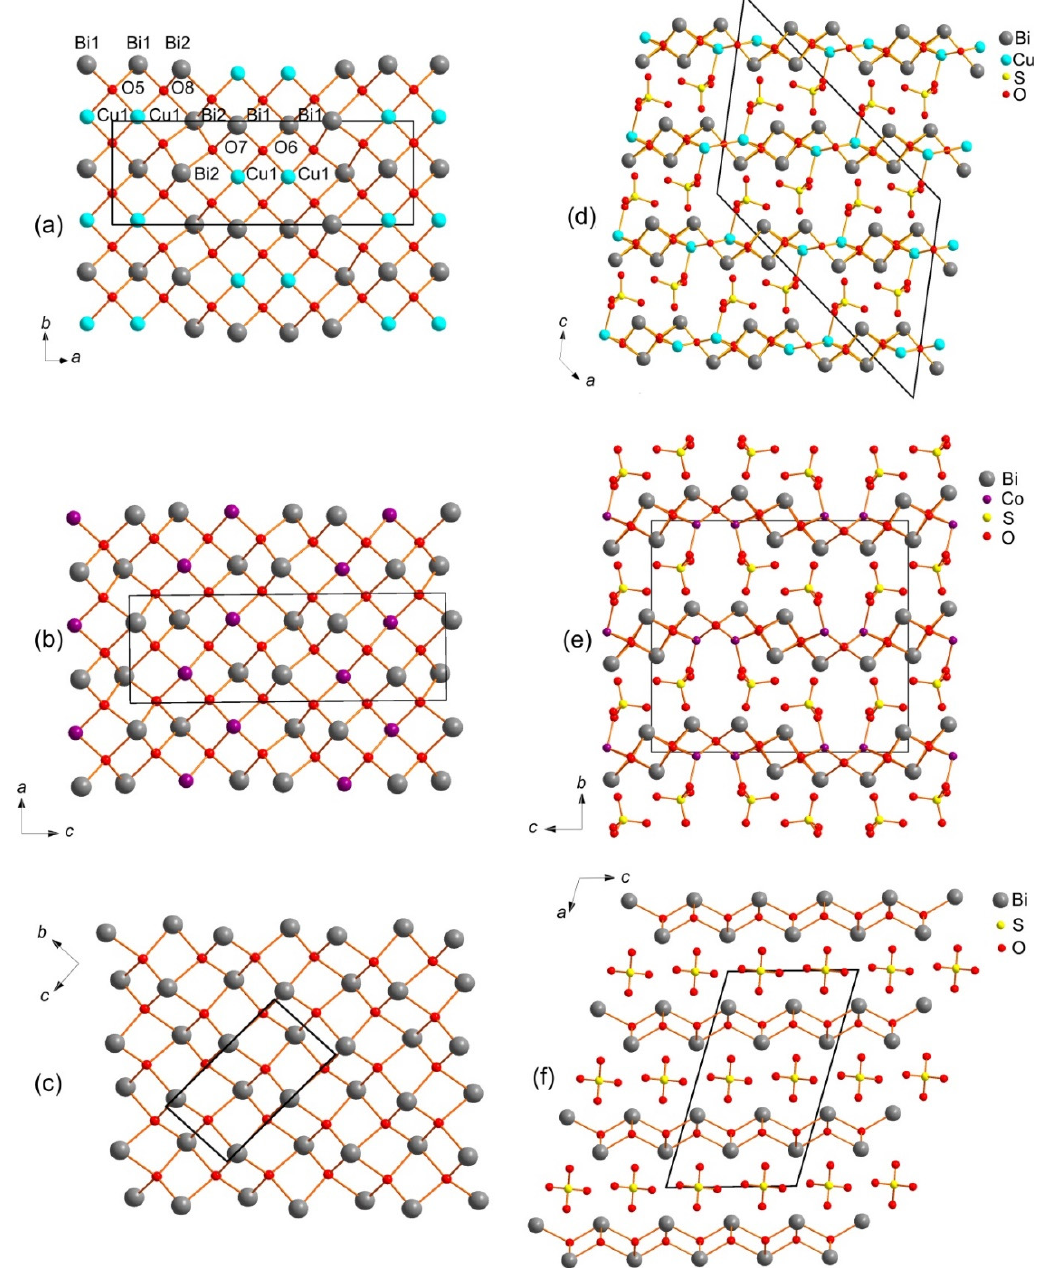
Figure 3. [Bi 2 CuO 3 ] 2+ layer ( a ) in the crystal structure of [Bi 2 CuO 3 ](SO 4 ), [Bi 2 CoO 3 ] 2+ layer ( b ) in the structure of [Bi 2 CoO 3 ](SO 4 ) and [Bi 2 O 2 ] 2+ layer ( c ) in the structure of [Bi 2 O 2 ](SO 4 ). General projections of the crystal structure of [Bi 2 CuO 3 ](SO 4 ) along the b axis ( d ), [Bi 2 CoO 3 ](SO 4 ) along the a axis ( e ), and [Bi 2 O 2 ](SO 4 ) along the b axis ( f ).